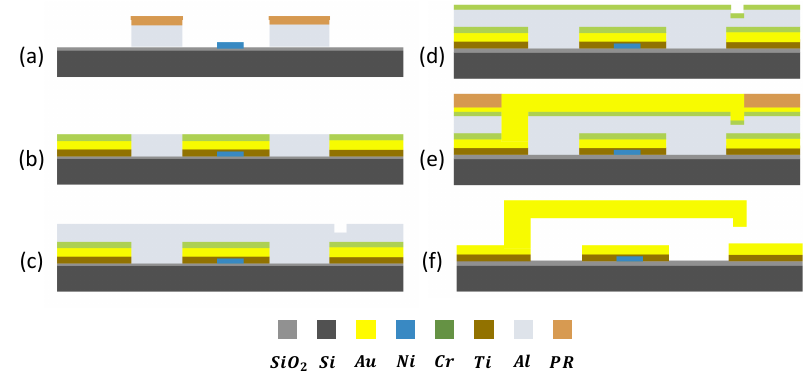
Figure 14. A simplified silicon-based MEMS switch fabrication flow. The fabrication process starts with circuit layer deposition using a lift-off technique in ( a , b ). After that, two aluminum sacrificial layers are deposited and dimple position is prepared with another lift-off in ( c ). Etching and plating were used to form the switch’s anchor in ( d ). After the gold seed layer and a photoresist patterning,